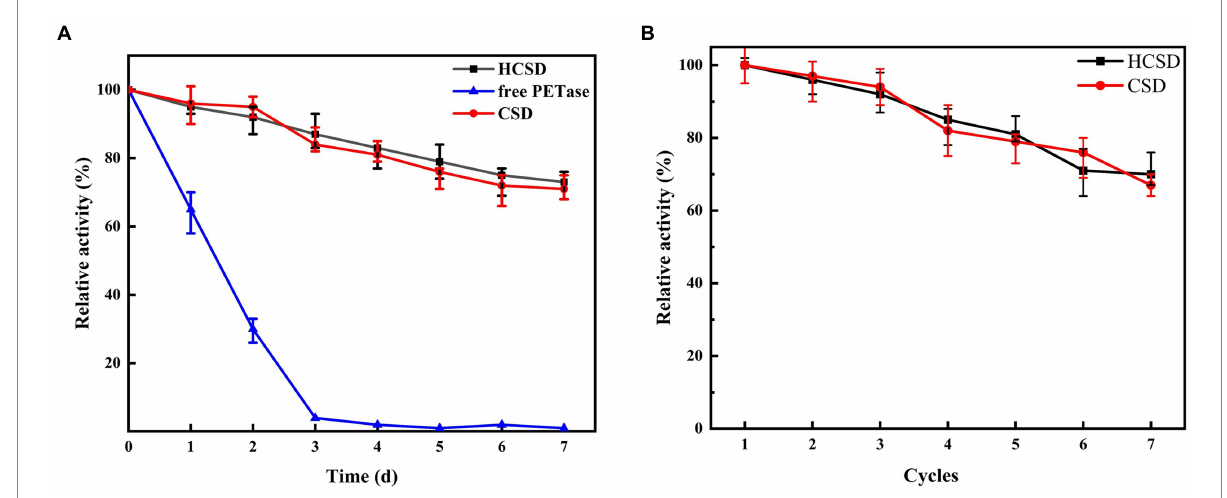
FIGURE 7 (A) The thermostability of PETase in HCSD and CSD systems compared to its free form. (B) Effect of recycling times on the hydrolytic activity PET f of PETase in HCSD and CSD systems. The enzyme activity was determined at 40 ° C in 50 mM glycine-NaOH buffer (pH 7.0) using as 4-NPB a substrate. Relative activity was calculated by assuming the initial activity as 100%.